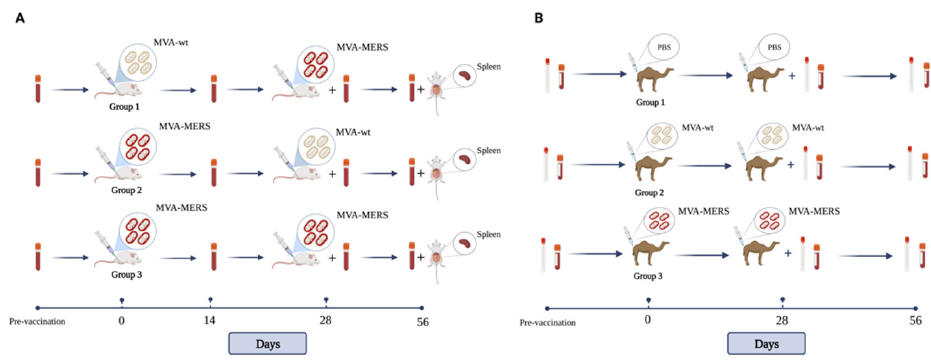
for a larger and clear